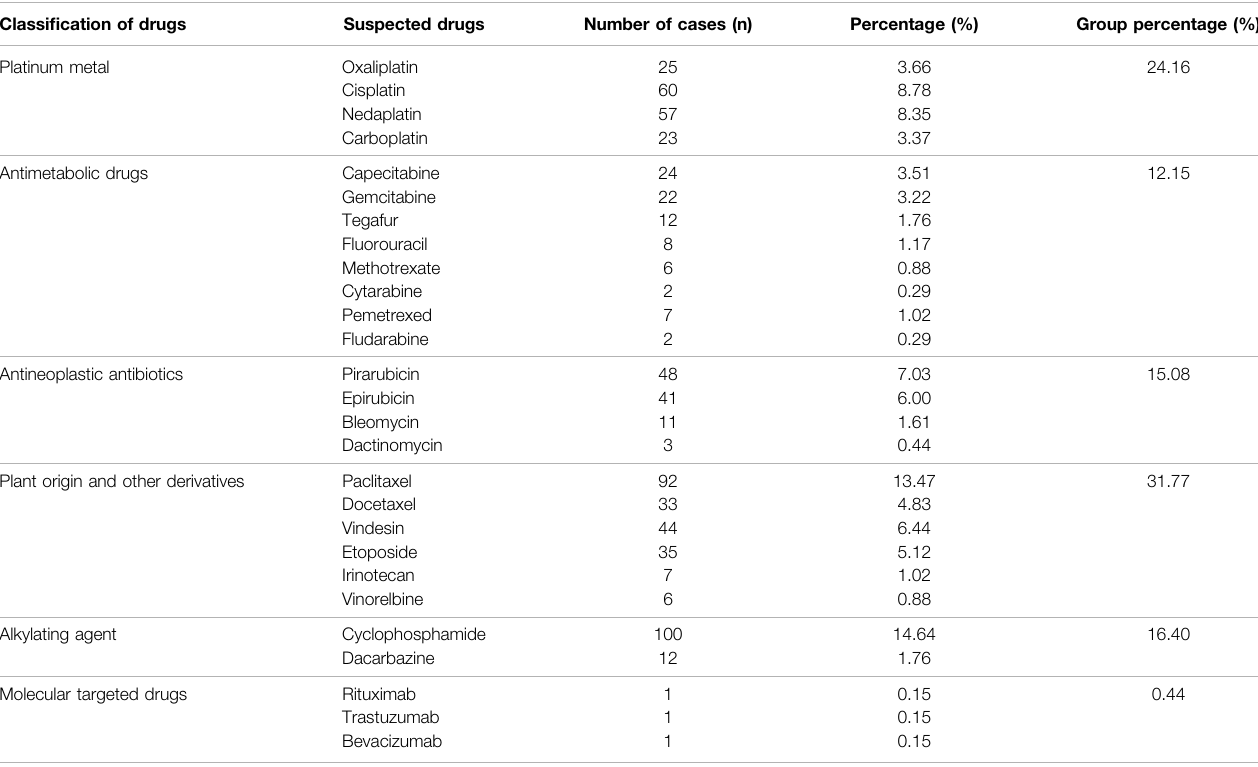
TABLE 2 | Classi fi cation of drugs leading to the occurrence of